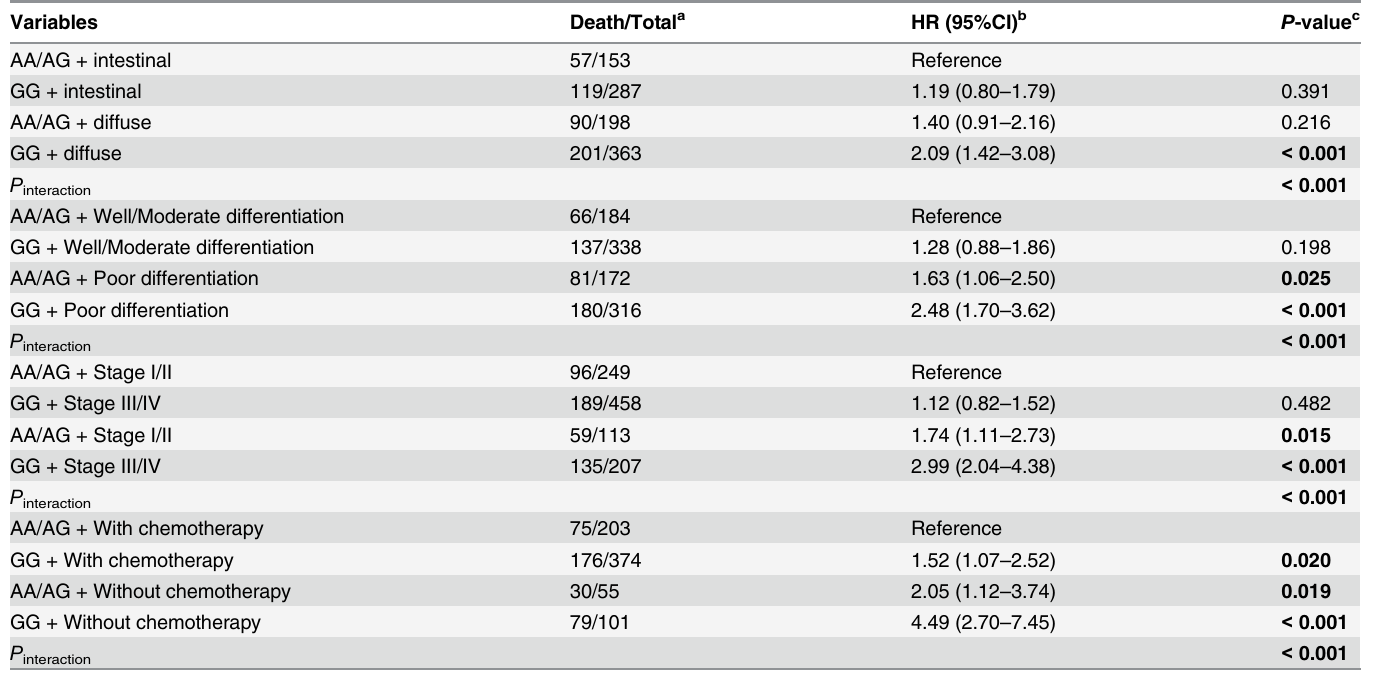
Table 2. Joint effect of rs1056560 genotypes and Lauren classification, differentiation, stage, chemotherapy on